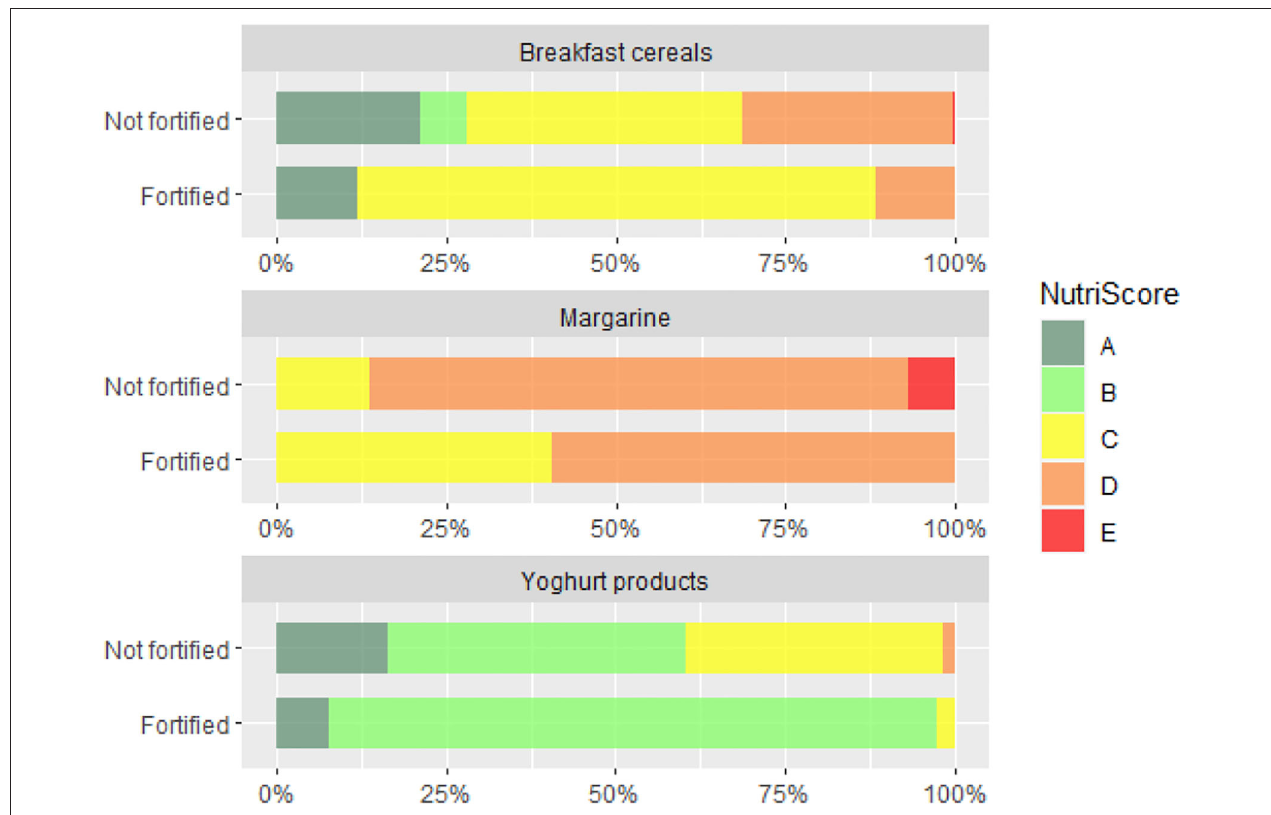
FIGURE 3 | Distribution of Nutri-Score grades (A-B-C-D-E) in breakfast cereals, margarine and yogurt products which are (1) not fortified and (2) fortified with vitamin D.